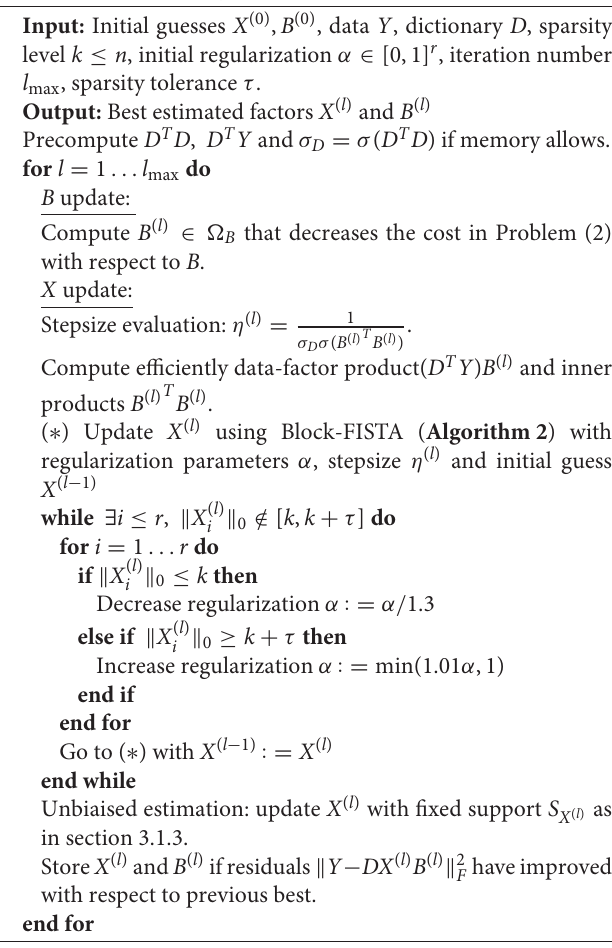
Algorithm 3 An AO algorithm for DLRA